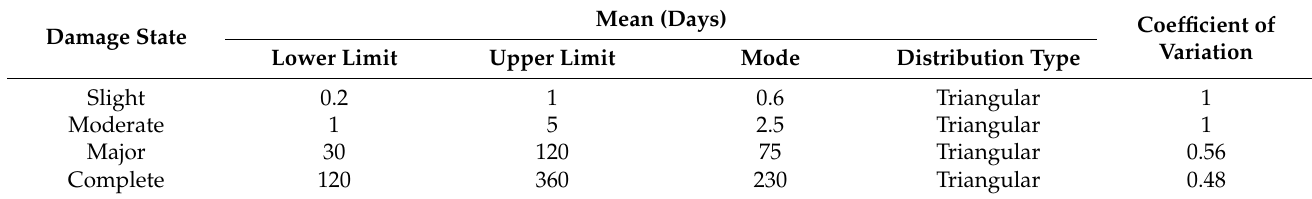
Table 2. Parameters associated with bridge restoration functionality [58].